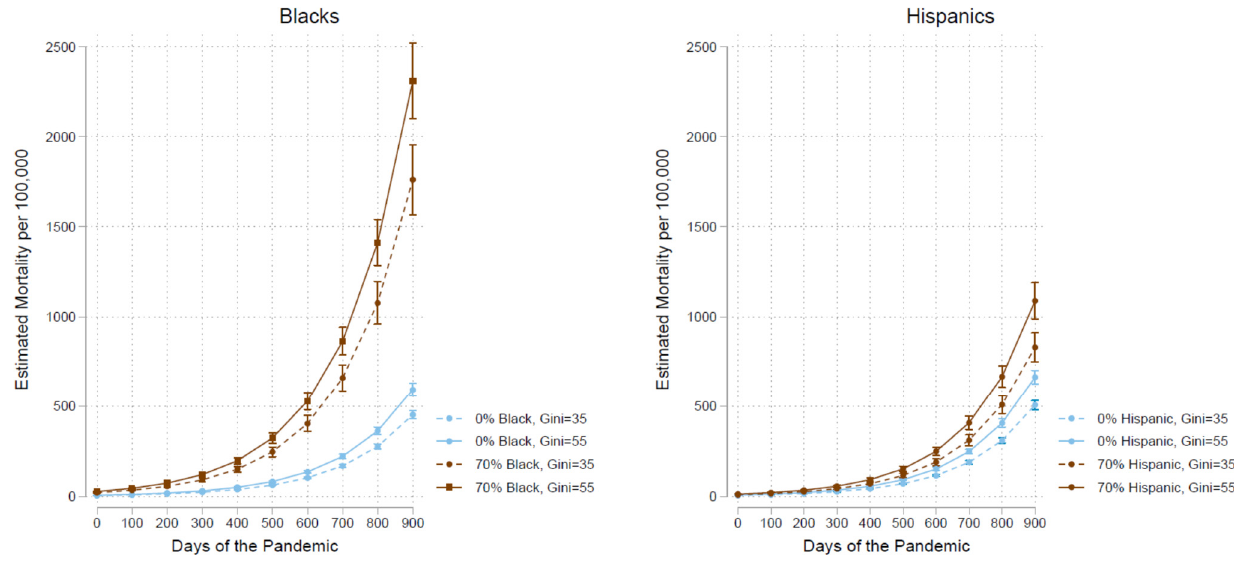
Figure 2. Mortality Estimations over 900 Days by Ethnic Composition and Income Inequality.